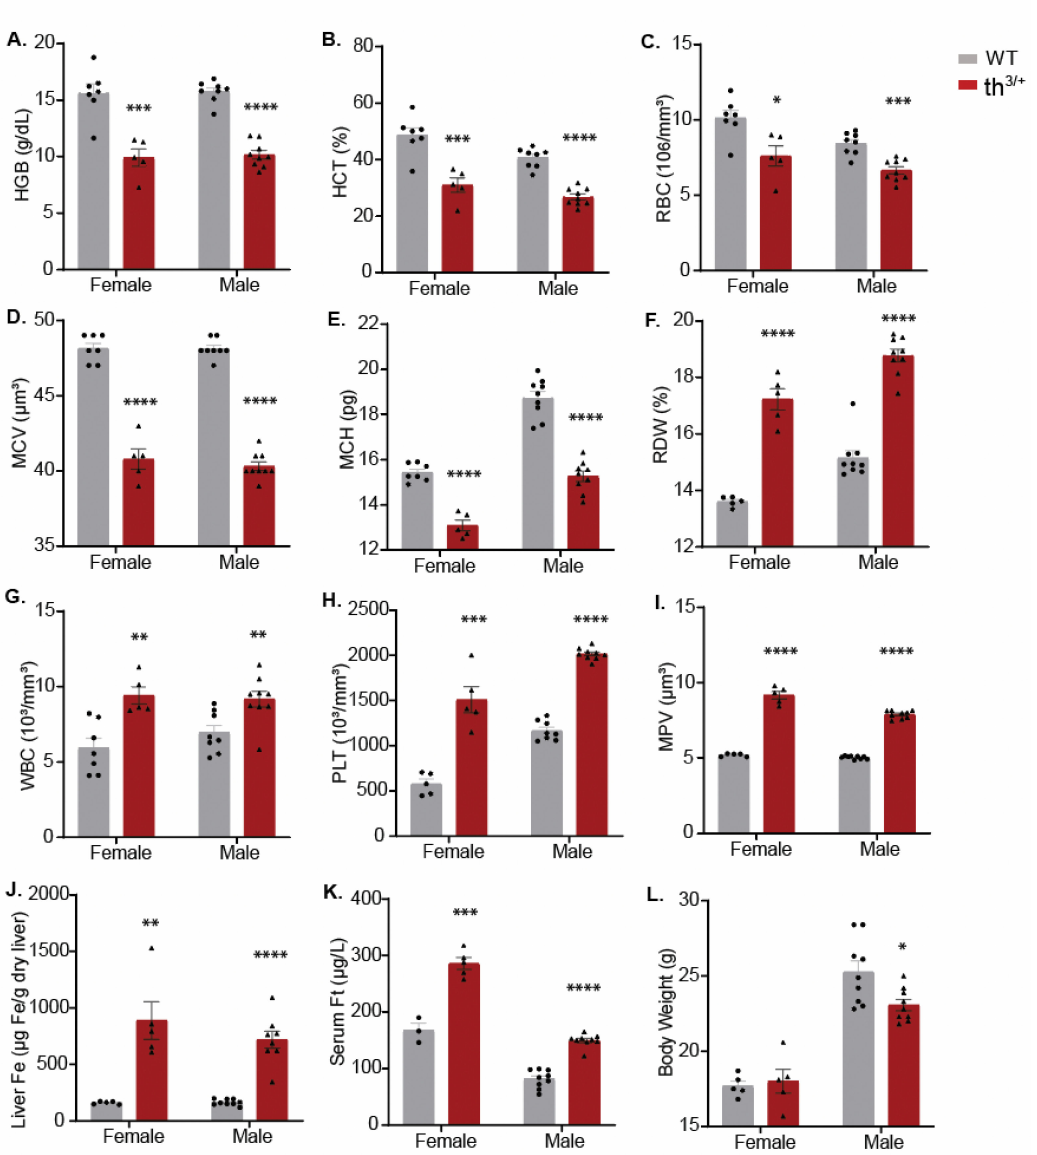
Figure 1. Hematological and iron phenotypes of 8-week-old th 3/+ mice. Male and female animals ( n = 3 wt and n = 5 th 3/+ ) were euthanized, and blood was collected for hematological analysis. Serum was prepared for ferritin assay, and livers were harvested for iron quantification. ( A ) Hemoglobin (HGB); ( B ) hematocrit (HCT); ( C ) red blood cells (RBC); ( D ) mean corpuscular volume (MCV); ( E ) mean corpuscular hemoglobin (MCH); ( F ) red cell distribution width (RDW); ( G ) white blood cells (WBC); ( H ) platelet (PLT) count; ( I ) mean platelet volume (MPV); ( J ) liver iron content; ( K ) serum ferritin; ( L ) body weight. Data are represented as mean ± SEM. Statistically significant differences across genotypes are indicated: * p < 0.05; ** p < 0.01; *** p < 0.001; **** p <